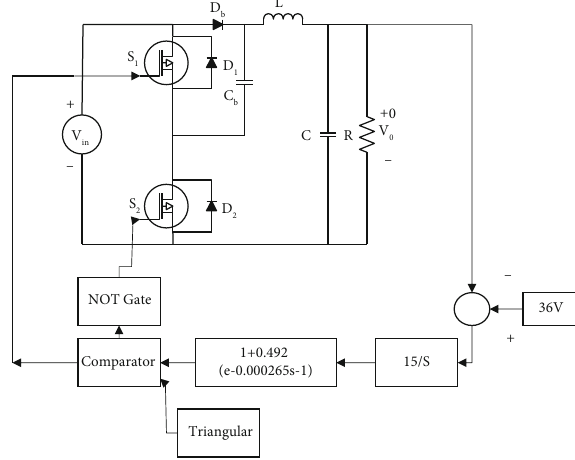
Figure 8: MATLAB/Simulink model of HPC for